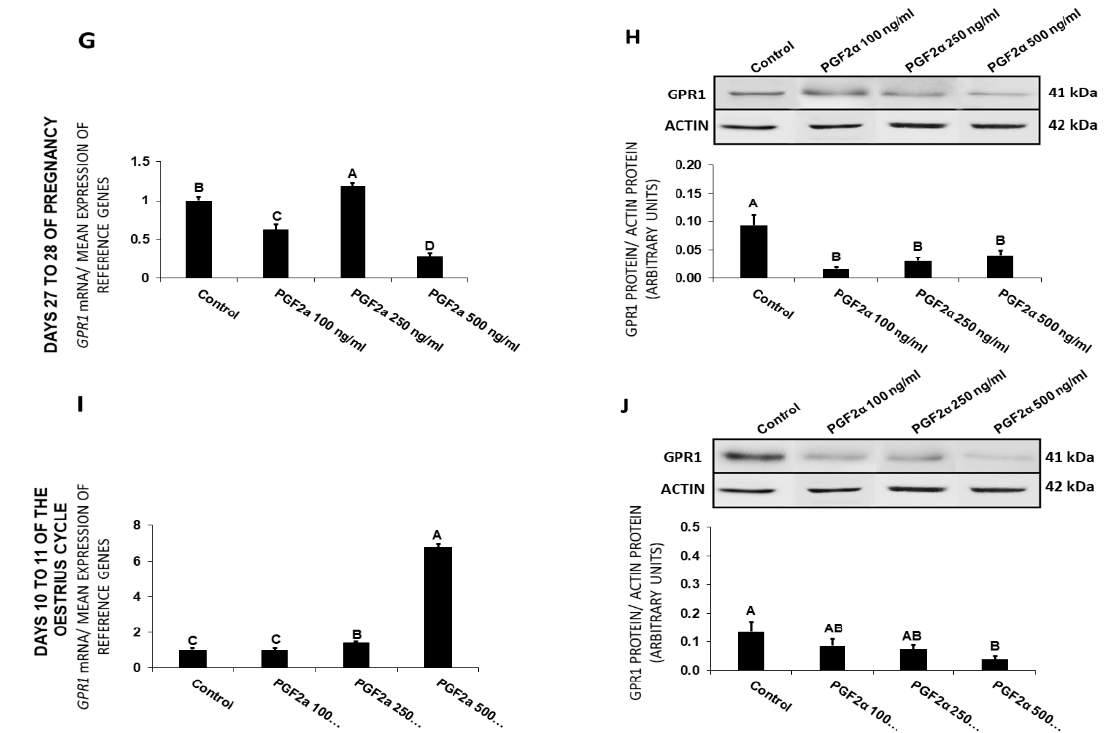
Figure 7. The influence of prostaglandin F 2 α (PGF 2 α ; 100, 250, 500 ng / mL) on G protein-coupled receptor 1 (GPR1) mRNA ( A , C , E , G , I ) and protein ( B , D , F , H , J ) expression in the porcine endometrium on days 10 to 11, 12 to 13, 15 to 16, and 27 to 28 of the pregnancy, and on days 10 to 11 of the estrous cycle. The gene expression was determined by quantitative real-time PCR. The protein concentration was determined by the western blotting analysis; upper panels: Representative immunoblots; lower panels: Densitometric analysis of GPR1 protein relative to actin protein. Results are reported as the means ± S.E.M. ( n = 5). Bars with di ff erent superscripts di ff er ( p <